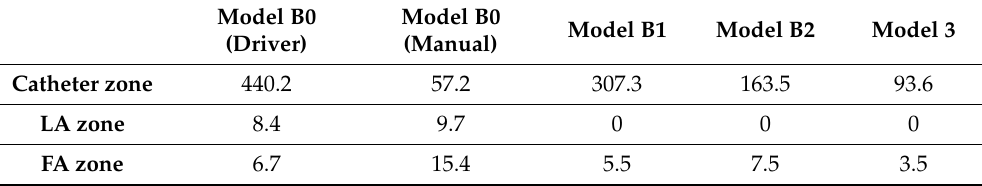
Table 4. Gradient of mass fraction of the anticancer agent in the catheter zone, LA zone, and FA zone in models